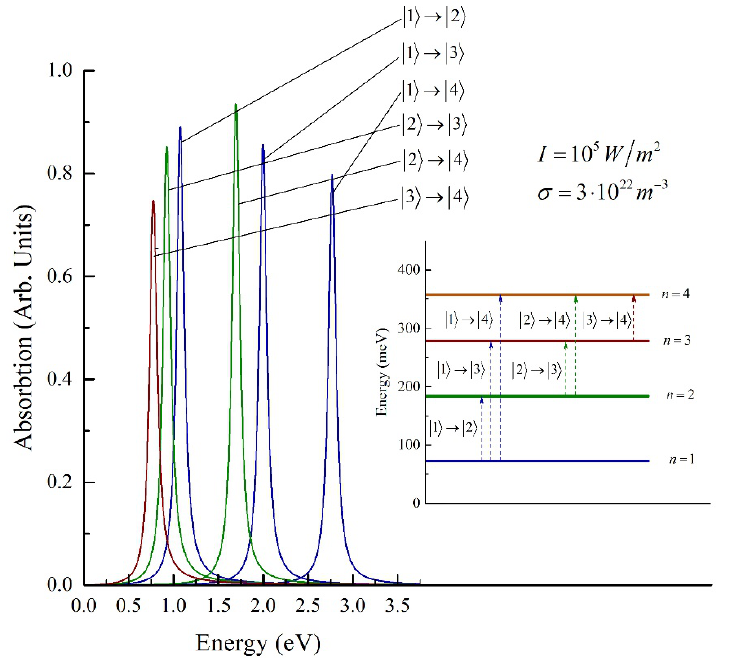
Figure 5. Dependence of the total absorption coefficient on the energy of the incident light for different transitions, (inset) schematic view of the energy diagram with quantum transitions.